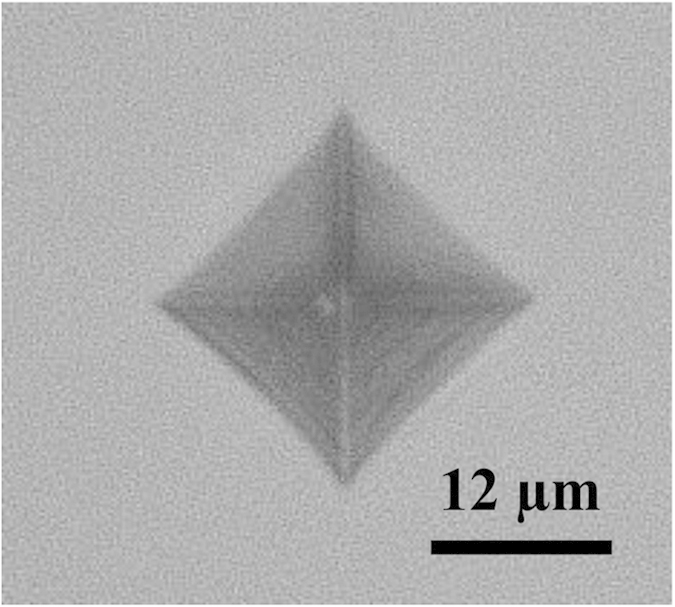
Vickers indentation imprint at 2.943 N for the 54Al2O3-46Ta2O5 glass.